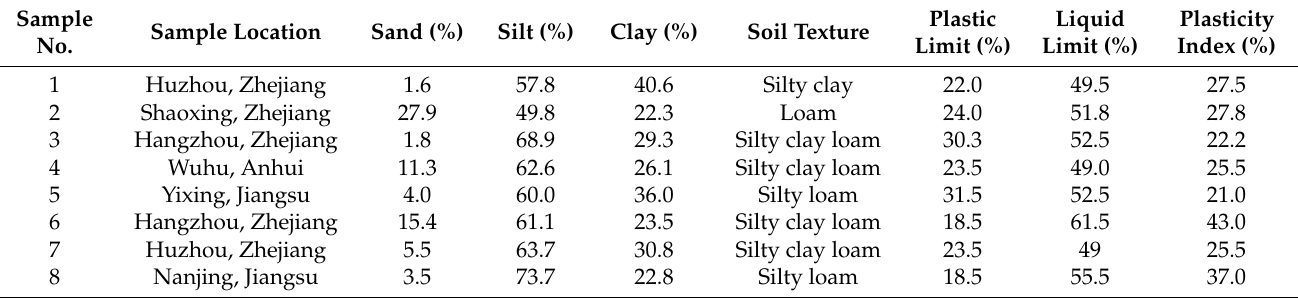
Table 1. Measured soil physical